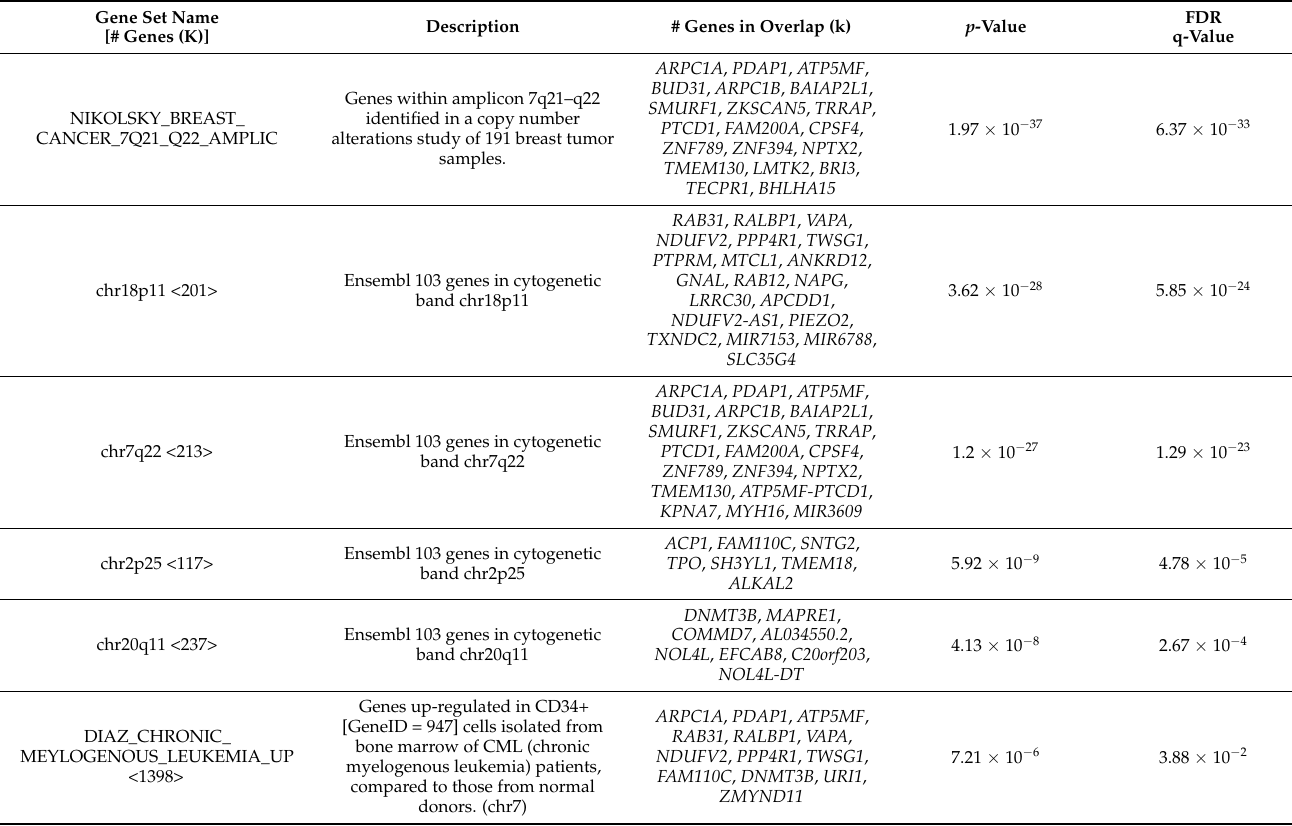
Table 1. CNV gain sites and overlap genes of FE25L (p124) compared to FE25 (p20) cells.